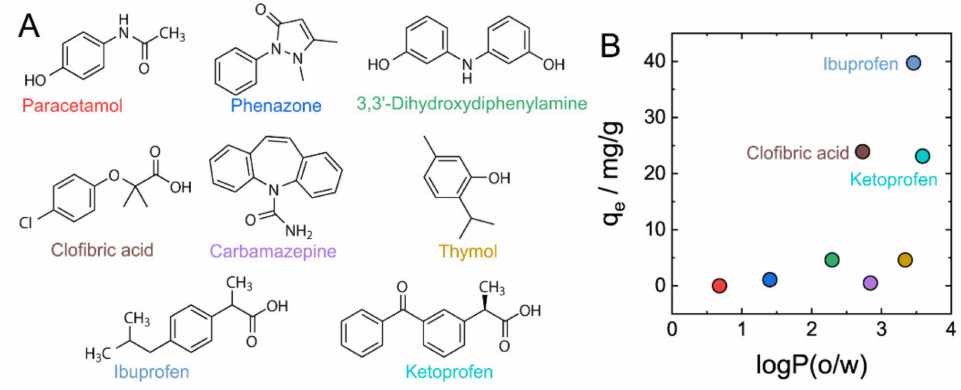
Figure 4. Adsorption of eight representative pharmaceuticals by DNA–CS hydrogels. ( A ). Chemical structures of studied pharmaceuticals. ( B ). Correlation between adsorption capacities of DNA–CS hydrogels for pharmaceuticals and their octanol/water partition